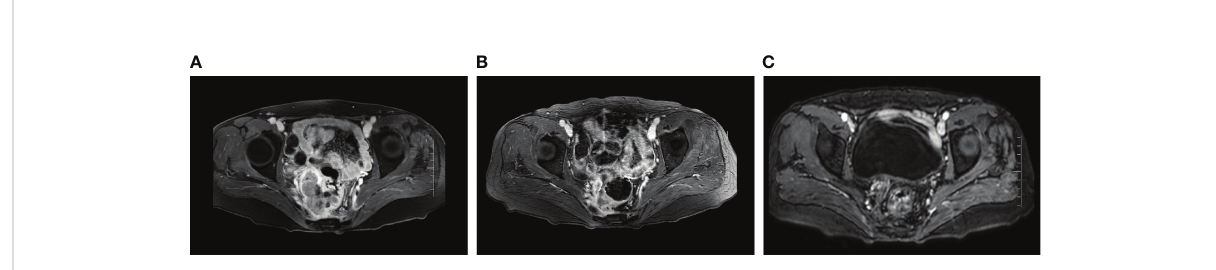
FIGURE 2 MRI images of local recurrent lesions during treatment. (A) Local recurrence of the last progression (January 2019). (B) MRI images after the last 6 cycles of non-platinum-based chemotherapy combined with bevacizumab (July 2021). (C) MRI images of 12 months after maintenance treatment using the PARP inhibitor Olaparib (July 2022).